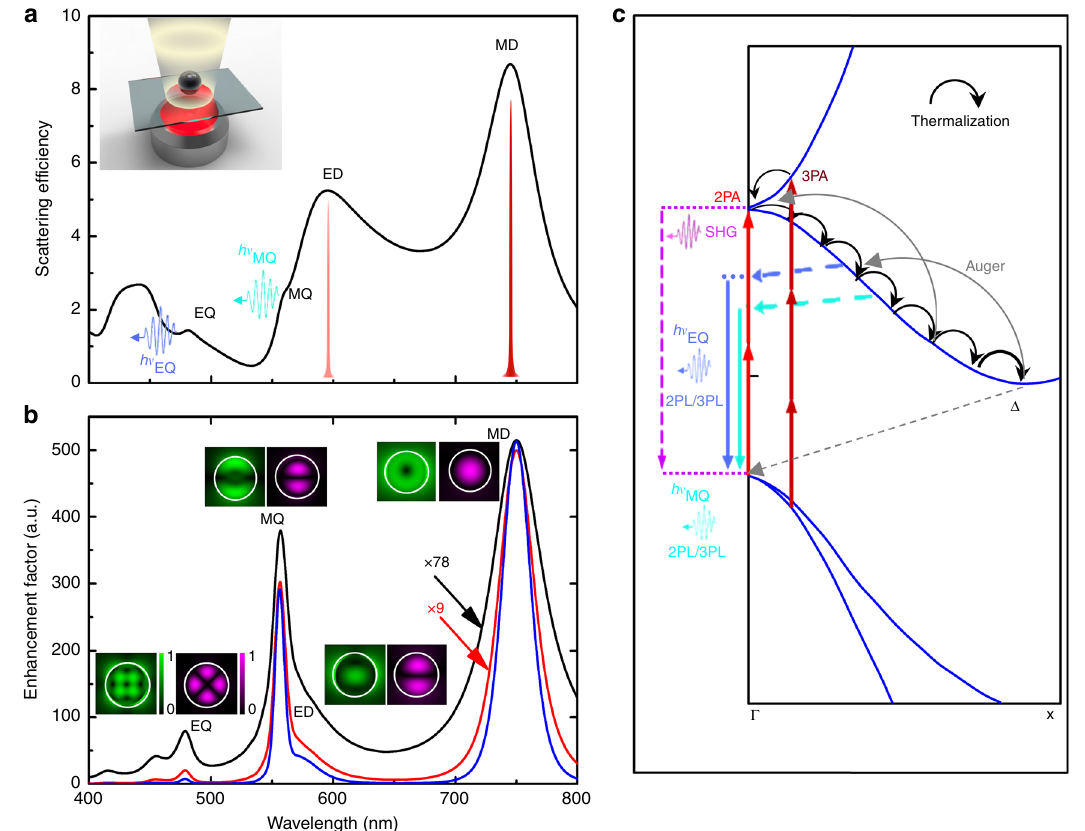
Fig. 1 Mechanism for lighting up silicon nanoparticles. a Principle of utilizing the magnetic dipole (MD) and electric dipole (ED) resonances of a silicon nanosphere (NS) to realize the excitation enhancement in two-photon-induced absorption (2PA) and three-photon-induced (3PA) and the magnetic quadrupole (MQ) and electric quadrupole (EQ) resonances to realize the emission enhancement in two-photon-induced luminescence (2PL) and three- photon-induced luminescence (3PL). The inset shows schematically the excitation of a silicon NS placed on a quartz substrate by using femtosecond laser light (red color) and the emission of up-converted luminescence (white light). The pulse-like symbols represent the wavelengths of the excitation laser which are resonant with the ED and MD resonances. b Spectra of I , I 2 , and I 3 calculated for a silicon NS with a diameter d = 192 nm. The electric (left) and magnetic (right) intensity distributions calculated at the MD, ED, MQ, and EQ resonances are presented as insets. c Energy band diagram of silicon in which the carrier excitation process through 2PA/3PA, the Auger effect that continuously lifts carriers from low-energy states to high-energy states, and the photon emission processes through second harmonic generation (SHG) and 2PL/3PL are schematically